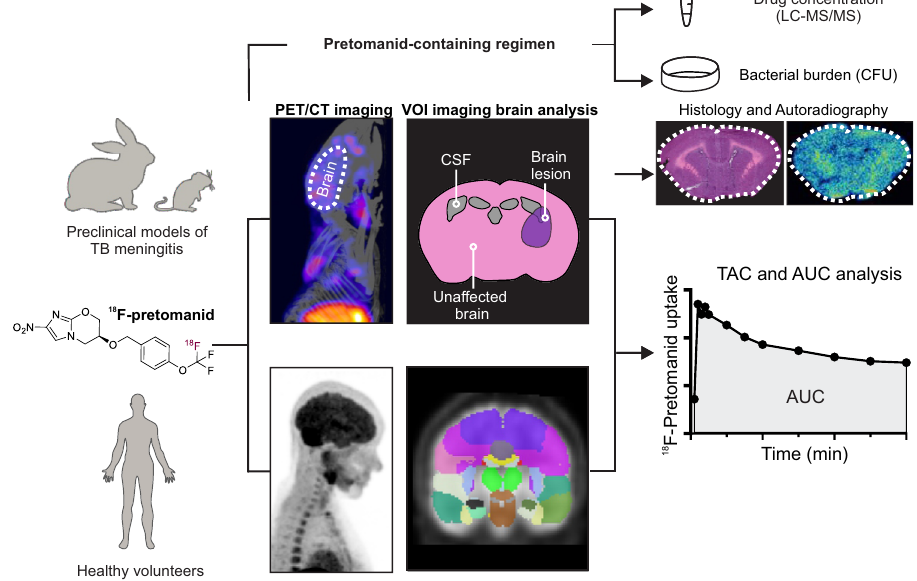
Fig. 1 | Schematic representation oftheexperimental design. Mouse and rabbit models of TB meningitis were used for radiotracer validation, pharmacokinetic characterization and pretomanid-containing regimen testing. 18 F-Pretomanid synthesiswasoptimizedforclinicaltranslationundercGMPand fi rst-in-humanPET